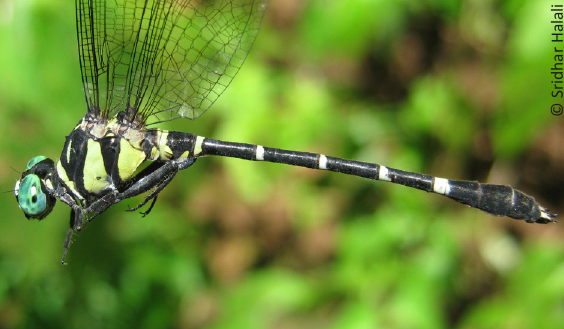
confluent with mesothoracic collar, mesepiron and metepimeron yellow separated by thick black stripe at posterolateral suture (Images 3 & 4). Legs: Black, base of trochanters with slight yellow pruinescense, femur black and stout, tibia and tarsus